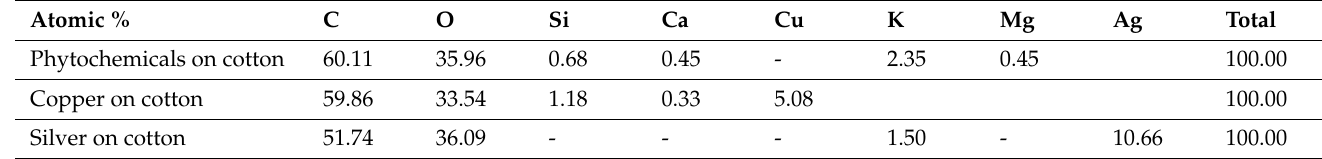
Table 4. Elemental composition for fabrics coated with phytochemicals, silver, and copper, respec- tively.